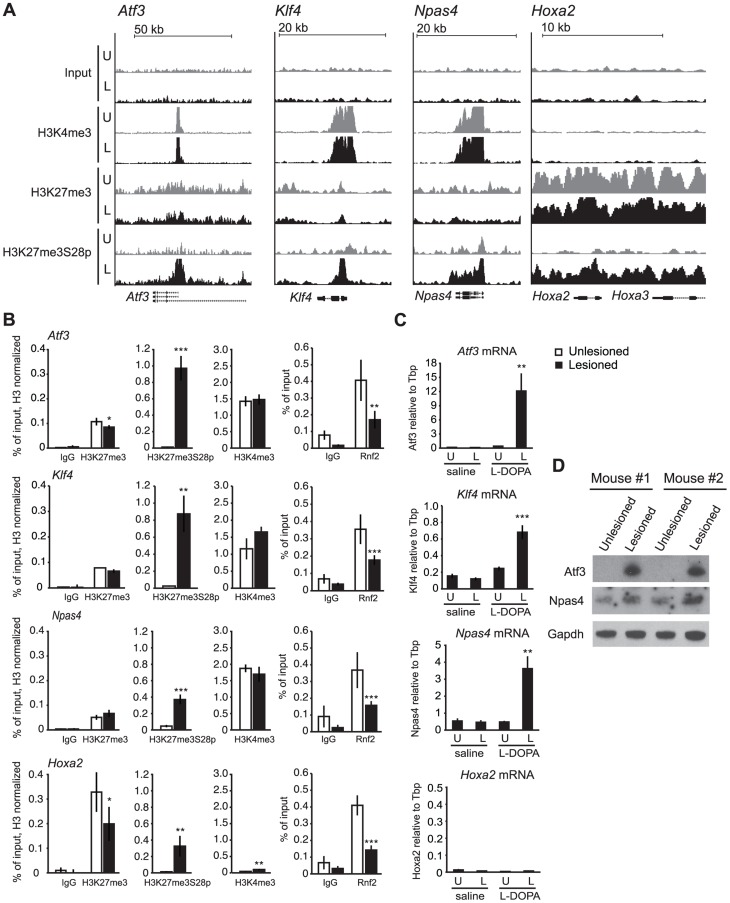
L-DOPA mediated H3K27me3S28 phosphorylation correlate with reduced PcG binding and derepression of genes.A) ChIP-seq signals for input chromatin, H3K4me3, H3K27me3 and H3K27me3S28p in unlesioned and lesioned striata after acute L-DOPA. Shown are genomic regions at the Atf3, Klf4, Npas4 and Hoxa2 genes. B) ChIP-qPCR on chromatin from unlesioned and lesioned striata after acute L-DOPA. Signals from histone marks were normalized to the total histone H3 using the same primers. Error bars represent standard deviation calculated from triplicate qPCR reactions. The signal in the lesioned striatum was compared to the signal in the unlesioned striatum, * p<0.1, ** p<0.05, *** p<0.001. C) RT-qPCR using primers for Atf3, Klf4, Npas4, Hoxa2 and Tbp (used for normalization) showing mRNA levels of the genes in saline control or acute L-DOPA (n = 3), in unlesioned and lesioned striata, respectively. Data are means ±S.E.M of the biological triplicates. *p<0.05, **p<0.01, ***p<0.001. D) Western blot showing induced protein levels for Atf3 and Npas4 in lesioned compared to unlesioned striata after acute L-DOPA treatment of two mice. Gapdh was used as loading control.